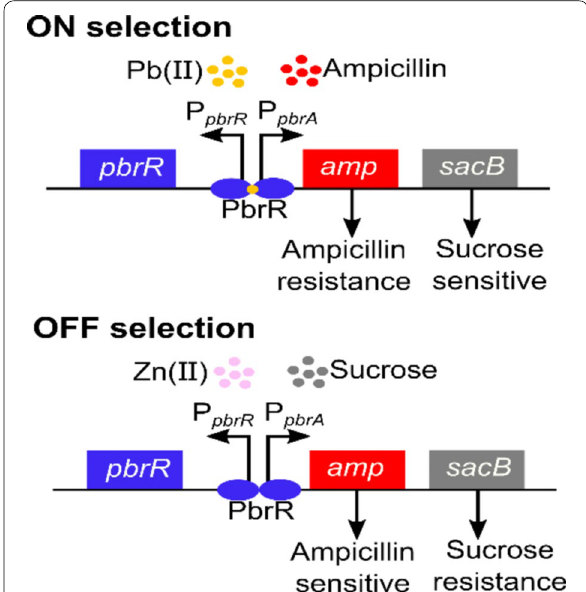
Fig. 1 Schematic of the dual selection system for directed evolution of PbrR